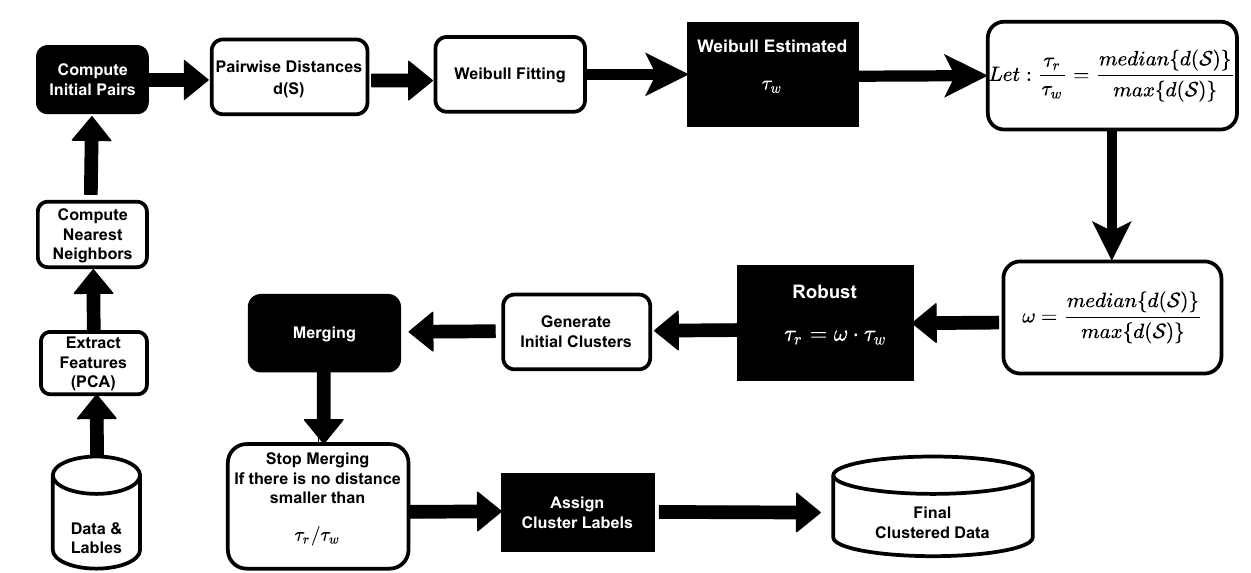
Figure 4. Diagram of Overall System Function. This figure shows the overall pipeline of PEACH. First, we extract deep features, then we compute the initial pairs, median{d(S)} and max{d(S)} for the EVT Estimation to compute the threshold τ r / τ w . Next, we use the nearest neighbors to generate initial clusters and the τ r / τ w will be used for merging to obtain final clustered